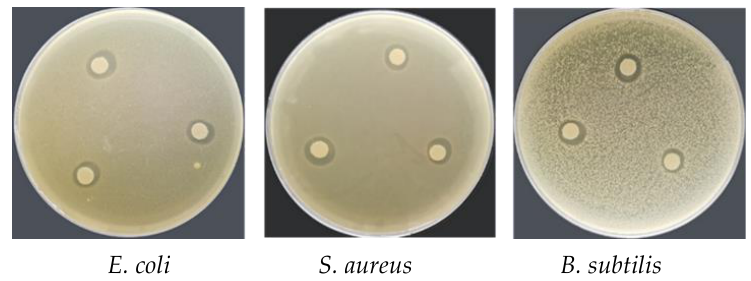
Figure 7. Antibacterial effect of CFEO-M on E. coli, S. aureus and B. subtilis .